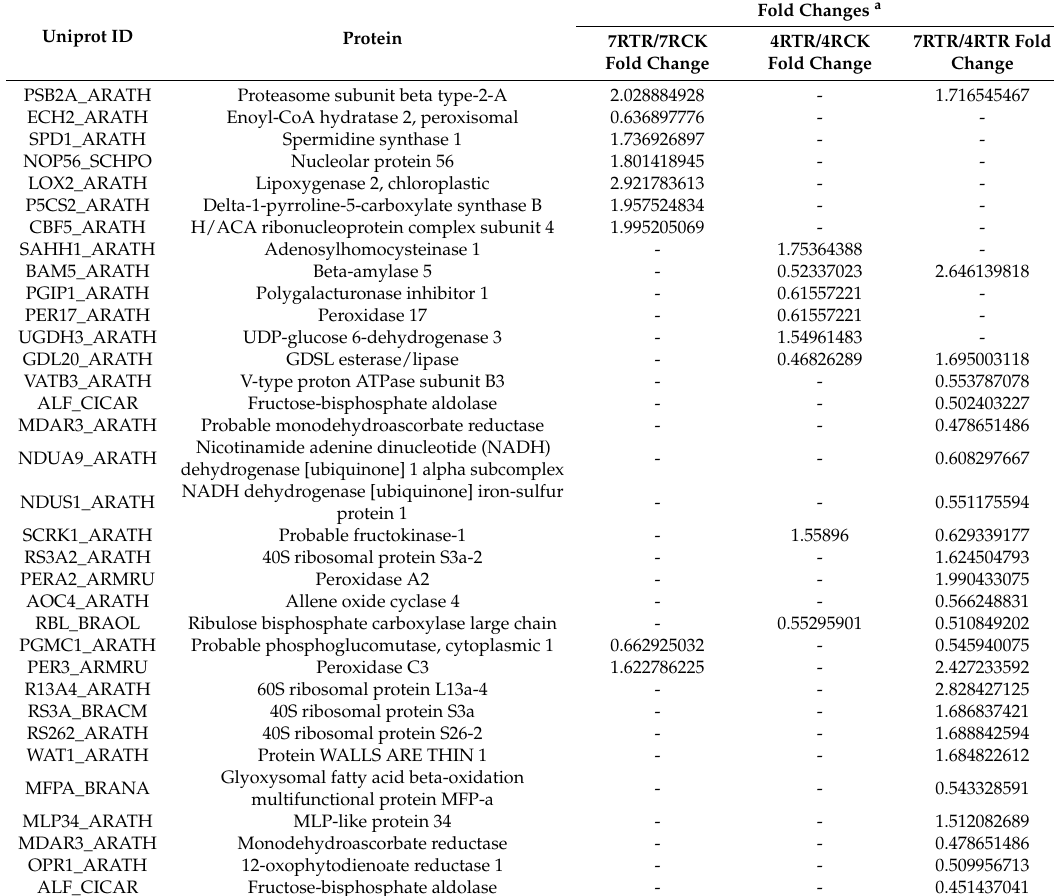
Table 1. Representation of DAPs in two varieties of winter turnip rape under freezing